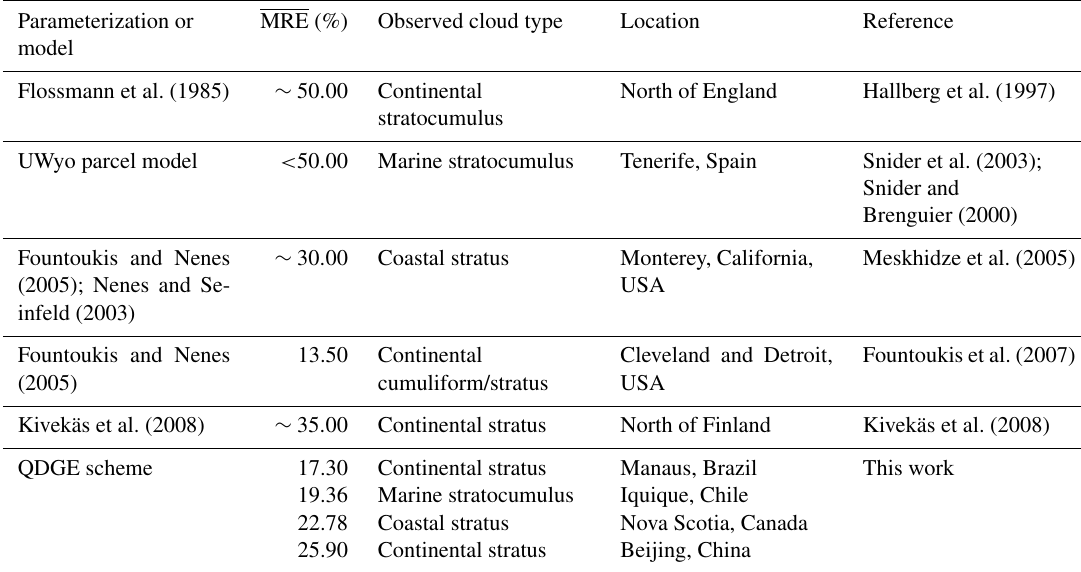
Table 3. Comparison of results from simulations with previous activation schemes (mainly referring to Fountoukis et al., 2007) and the QDGE method.